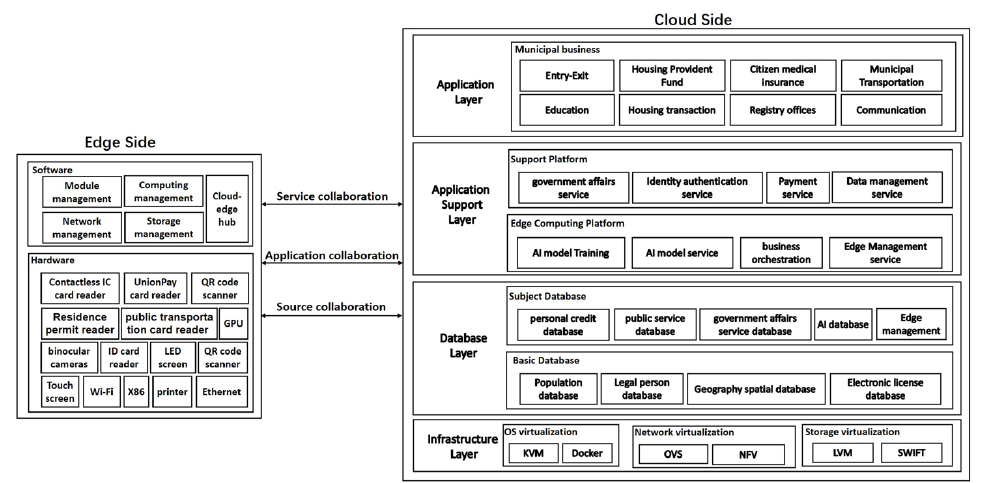
Figure 2. The cloud-edge collaboration reference